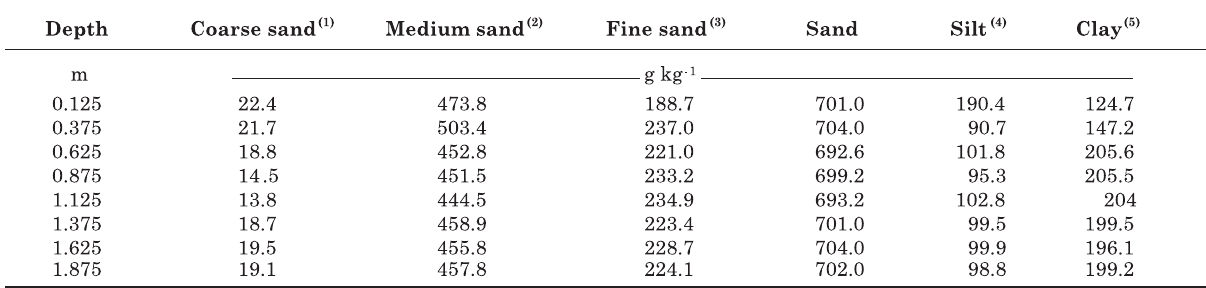
Table 1. Soil texture for 25 cm soil layers according to ABNT (NBR